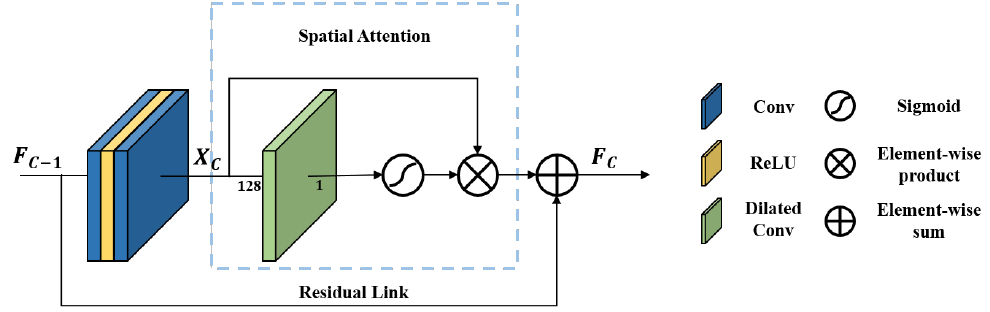
Figure 2. The diagram of residual spatial attention (RSA)